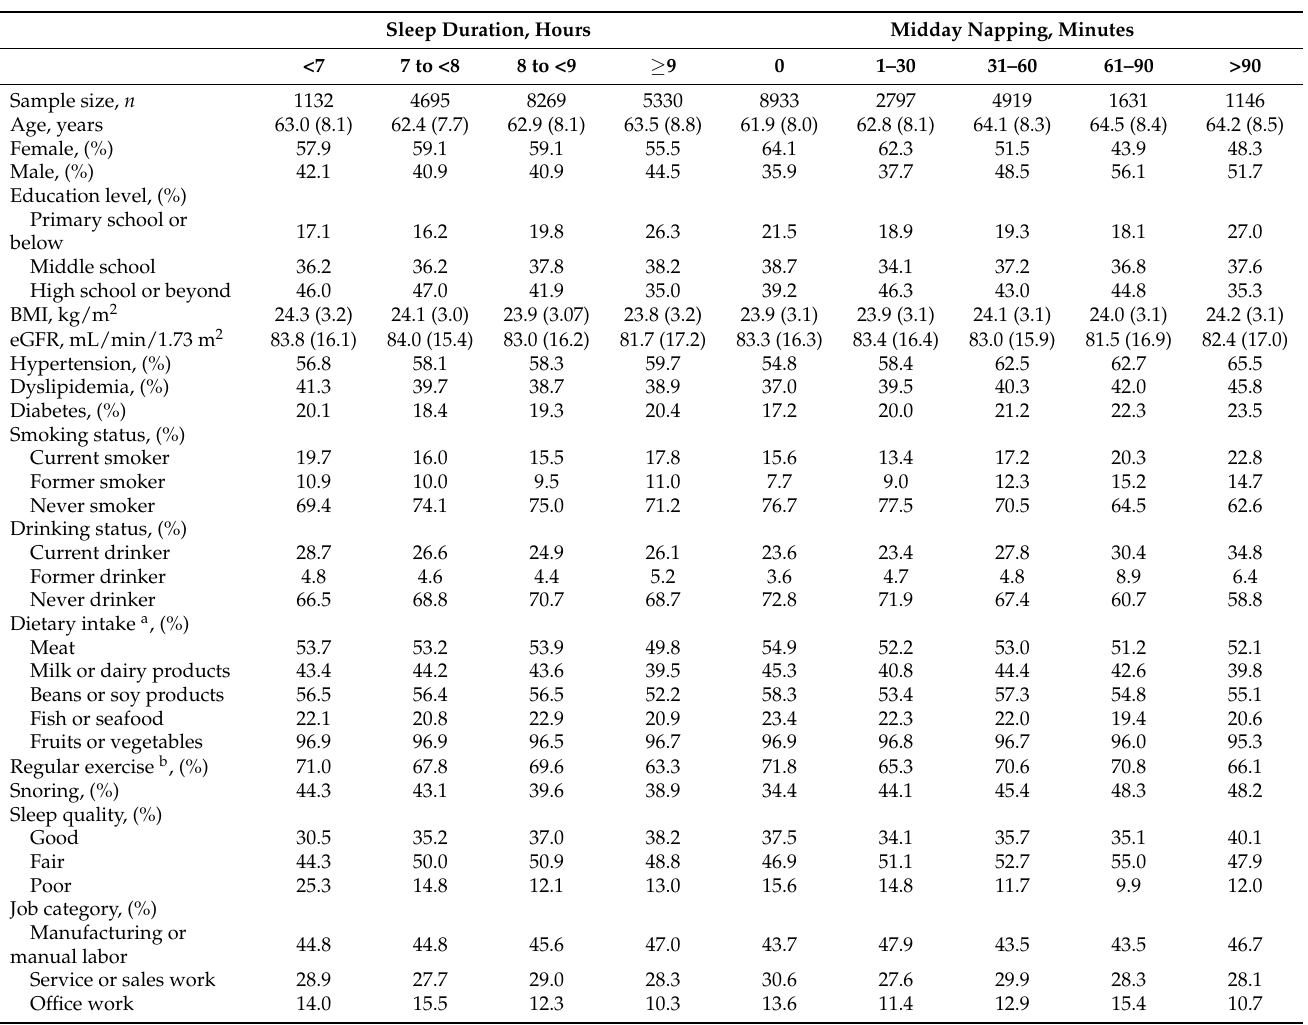
Table 1. Baseline characteristics of the total study population according to sleep duration and midday napping (N =